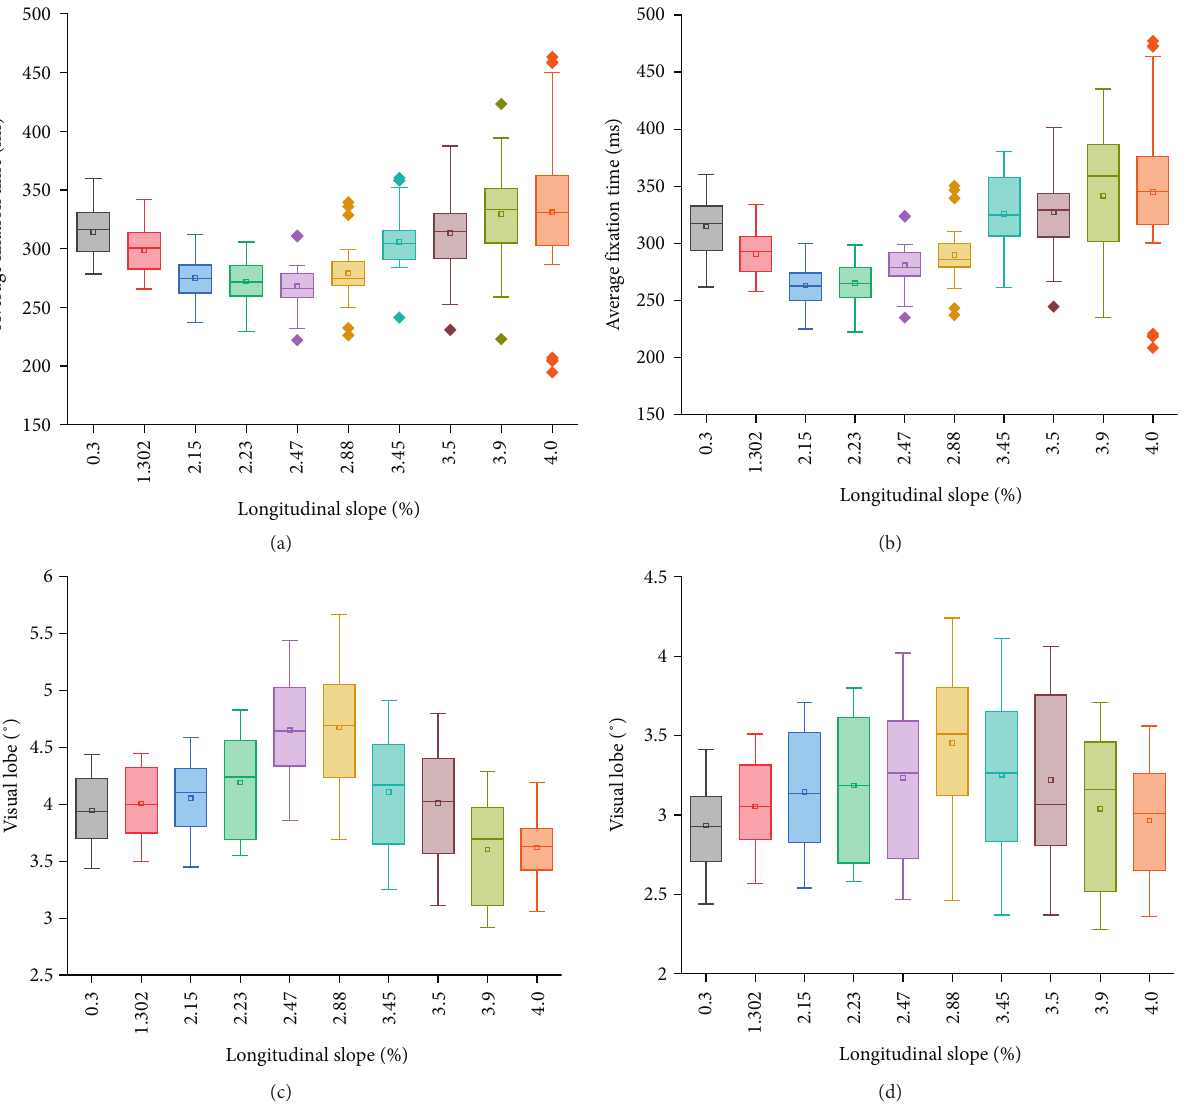
Figure 2: The box plot of the average fixation time and visual lobe of drivers under different longitudinal slopes in the uphill and downhill sections. (a) The average fixation time under different longitudinal slopes in the uphill section, (b) the average fixation time under different longitudinal slopes in the downhill section, (c) the visual lobe under different longitudinal slopes in the uphill section, and (d) the visual lobe under different longitudinal slopes in the downhill